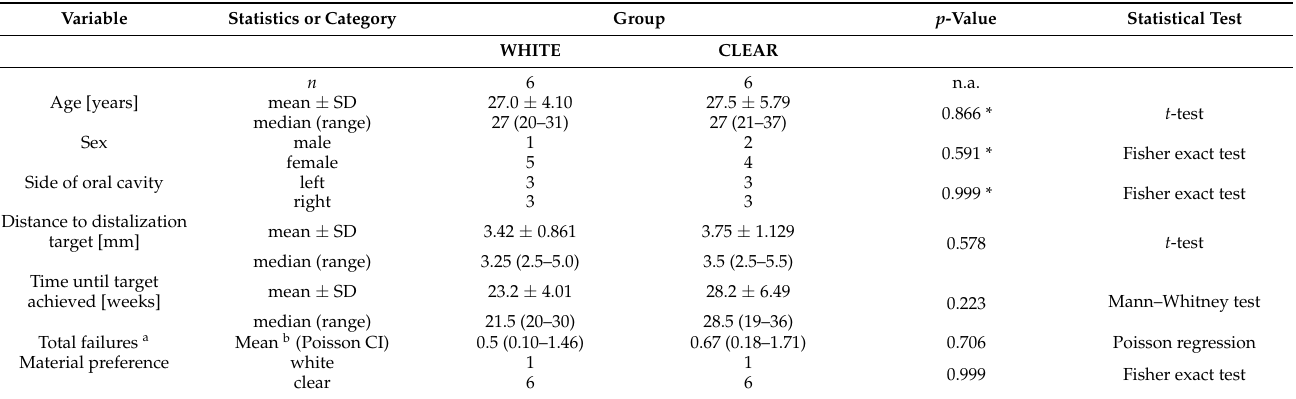
Table 5. Patients’ characteristics and bivariate analysis with Poisson